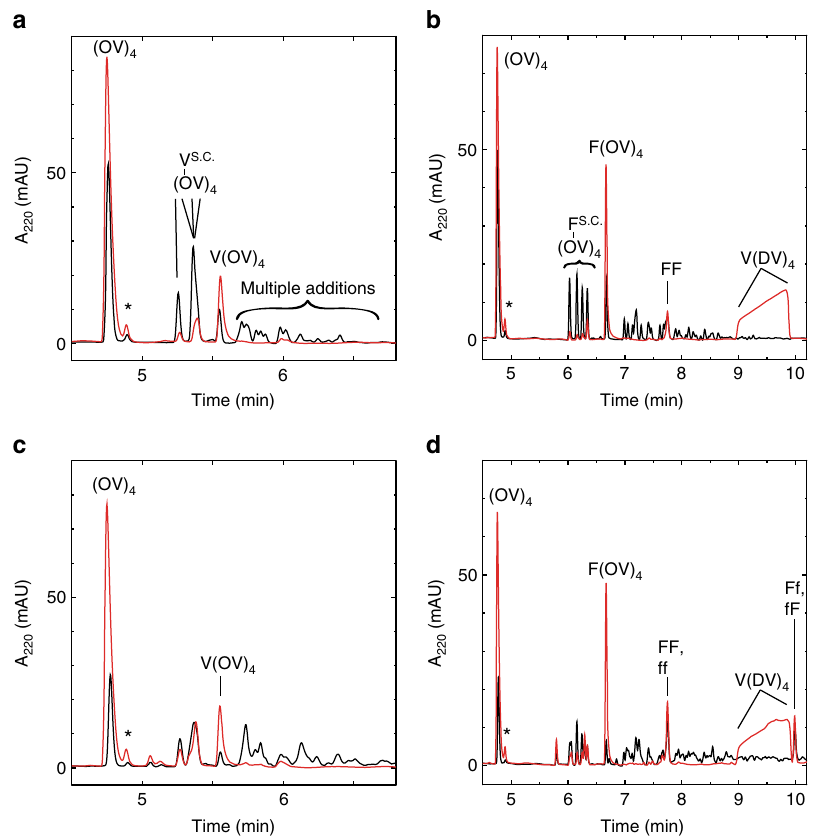
Fig. 5 Regio-speci fi c and stereo-speci fi c addition reactions with the (OV) 4 /V(DV) 4 amyloid. Reverse-phase HPLC chromatograms of the addition reactions with valine ( a ), phenylalanine ( b ), DL-valine ( c ) and DL- phenylalanine ( d ). Reactions with just substrate (OV) 4 are the black traces and those with the amyloid (OV) 4 /V(DV) 4 are the red ones. The ornithine sidechain addition products are indicated with the superscript S.C. The * indicates the C-terminal deamidated substrate that remained after puri fi cation. The (OV) 4 concentration was 100 μ M, the V(DV) 4 concentration was 120 μ M and amino acids were all at 200 μ M of each enantiomer. The addition product to the N-terminus was identi fi ed via NMR and reverse-phase HPLC analysis of an authentic V (OV) 4 control peptide (see Supplementary Fig.